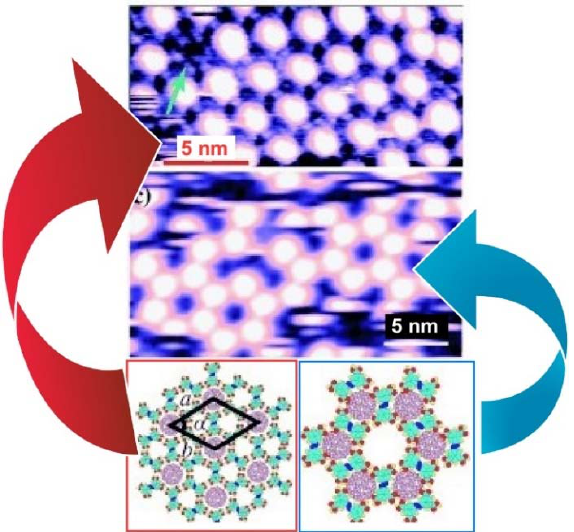
Figure 8. Two ‐ dimensional C 60 arrangement on two types of cavities formed by an azobenzene de ‐ Figure 8. Two-dimensional C 60 arrangement on two types of cavities formed by an azobenzene rivative (NN4A). Reprinted with permission from [118]. Copyright 2009 Wiley ‐ VCH. derivative (NN4A). Reprinted with permission from [118]. Copyright 2009